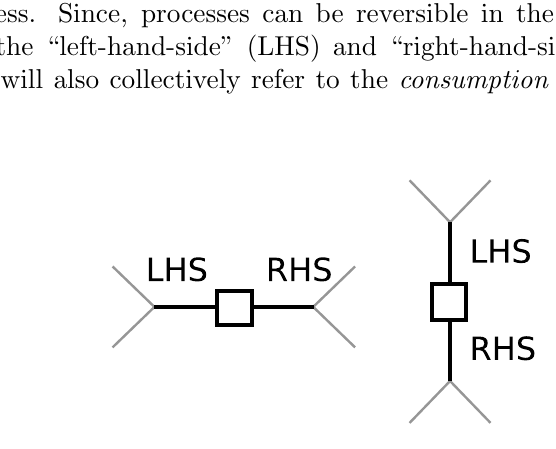
Figure 3.3: An illustration of the “sidedness” of a process. The designation of LHS and RHS is essentially